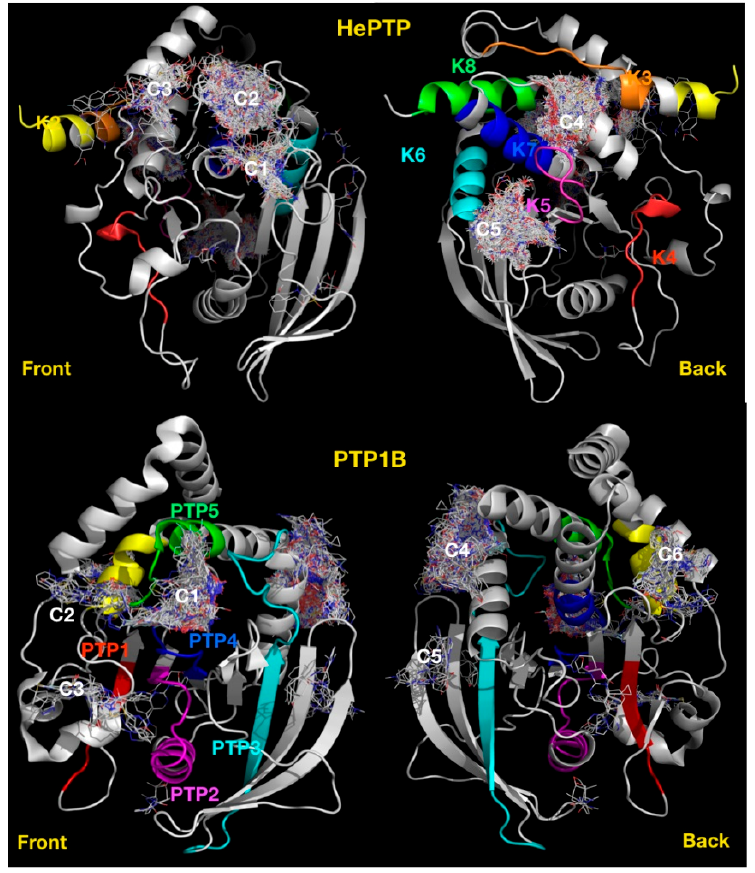
Figure 6. Blind docking cluster comparison between HePTP and PTP1B. The structure of HePTP ( top ) is shown as a grey cartoon, key functional KIM specific motifs [33] have been coloured on the HePTP structure, K2 in yellow, K3 in orange, K4 in red, K5 in magenta, K6 in cyan, K7 in blue, K8 in green. Compounds are shown as lines. Ligand clusters with more than ten compounds are numbered: C1, active site; C2, open form pocket; C3, substrate-binding site; C4, centred on K3, K5 and K7 motifs; C5, centred on K5–K7 motifs. The structure of PTP1B is shown as a grey cartoon ( bottom ), front view and back view. Clusters are numbered: C1, active site; C2, secondary pTyr site; C3, centred on L41; C4, allosteric binding site; C5, centred on V155; and C6, centred on E252. Key PTP motifs [33] have been coloured on the structure: PTP1 in red; PTP 2, magenta; PTP 3, cyan; PTP 4, blue; PTP 5, green; and PTP6, yellow.